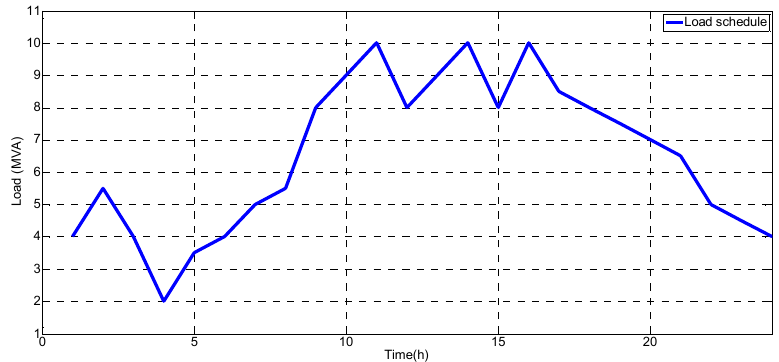
Figure 23. Load prediction schedule for simulation.